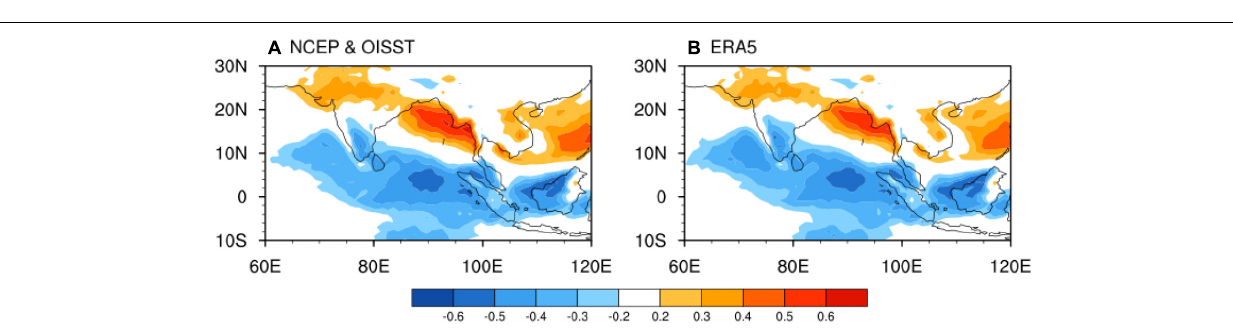
FIGURE 5 | Correlation coefficients between intraseasonal precipitation anomalies and the CIO mode index obtained with (A) NCEP and OISST and (B) ERA5 during boreal summer